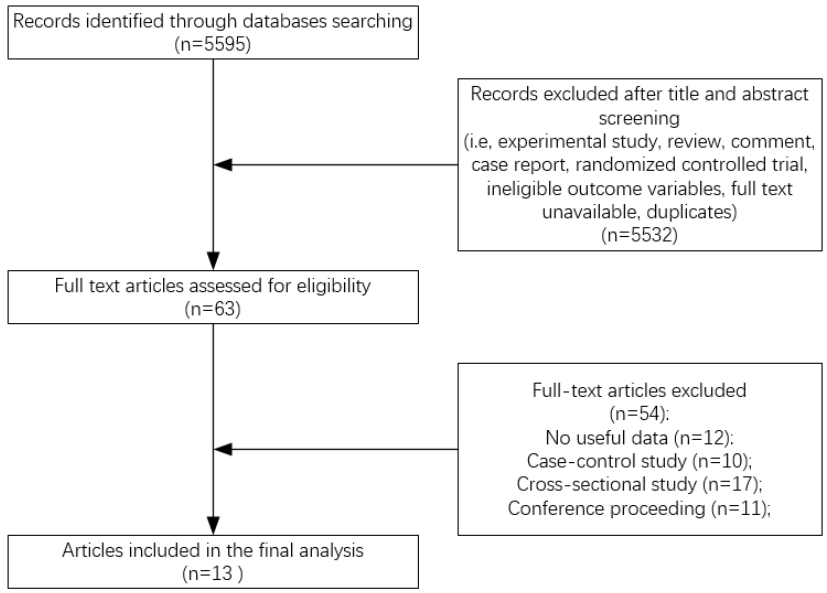
Figure 1. Flow diagram of literature search.